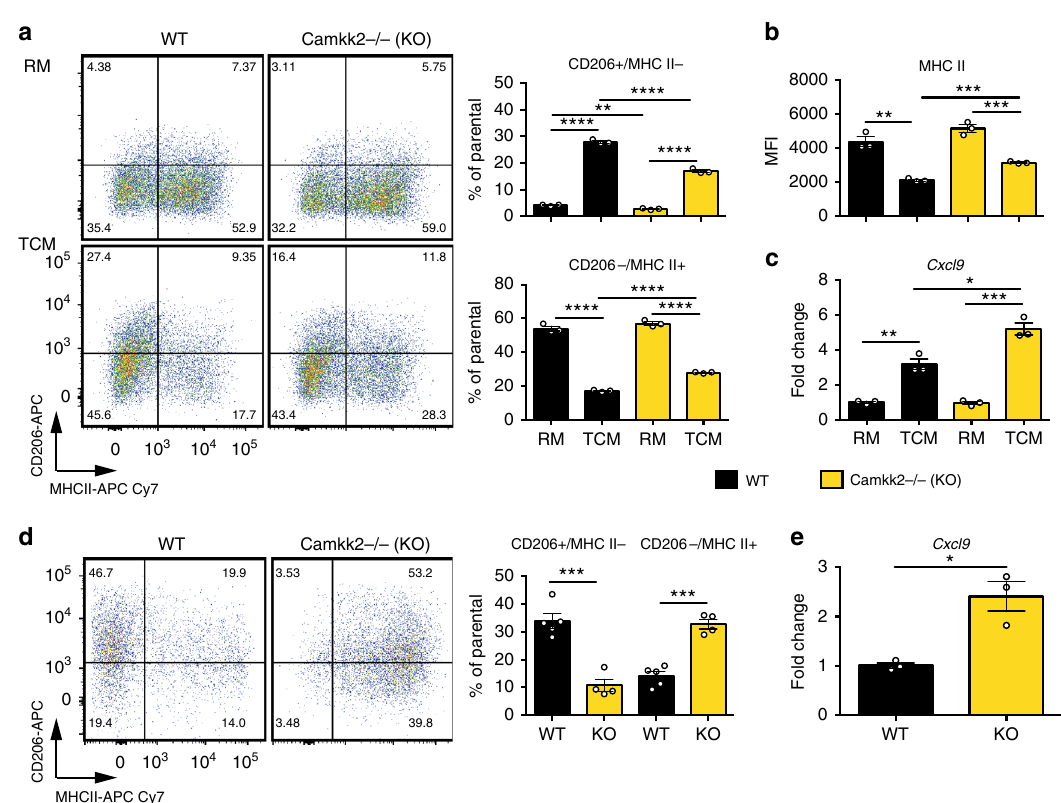
Fig. 6 Phenotype of WT and Camkk2 − / − BMDM generated in the presence or absence of tumor-conditioned medium. WT and Camkk2 − / − BMDM were generated in the presence of RM or TCM. a Left: CD206 and MHC II expression on CD11b + F4/80 + gated BMDM. Right: percentages of CD206 + /MHC II − and CD206 − /MHC II + subsets (mean ± SEM; N = 3 biological replicates). b Expression of MHC II on CD11b + F4/80 + gated BMDM (mean of MFI ± SEM; N = 3 biological replicates). c Cxcl9 expression (mean ± SEM; N = 3 biological replicates). These experiments were replicated at least three times. d Tumors of comparable size (500 – 700 mm 3 ) were removed from WT and Camkk2 − / − mice, and myeloid cells were then identi fi ed and sorted by fl ow cytometry. Bar graph reports mean ± SEM of CD206 + /MHC II − and CD206 − /MHC II + TAM percentages gated on “ Mac ” subset in the Supplementary Fig. 2 ( N = 5 and 4 tumors removed from WT and Camkk2 − / − mice, respectively). e Cxcl9 expression in TAM sorted from E0771 tumors removed from WT and Camkk2 − / − mice (mean ± SEM; N = 3 and 3 tumors for each